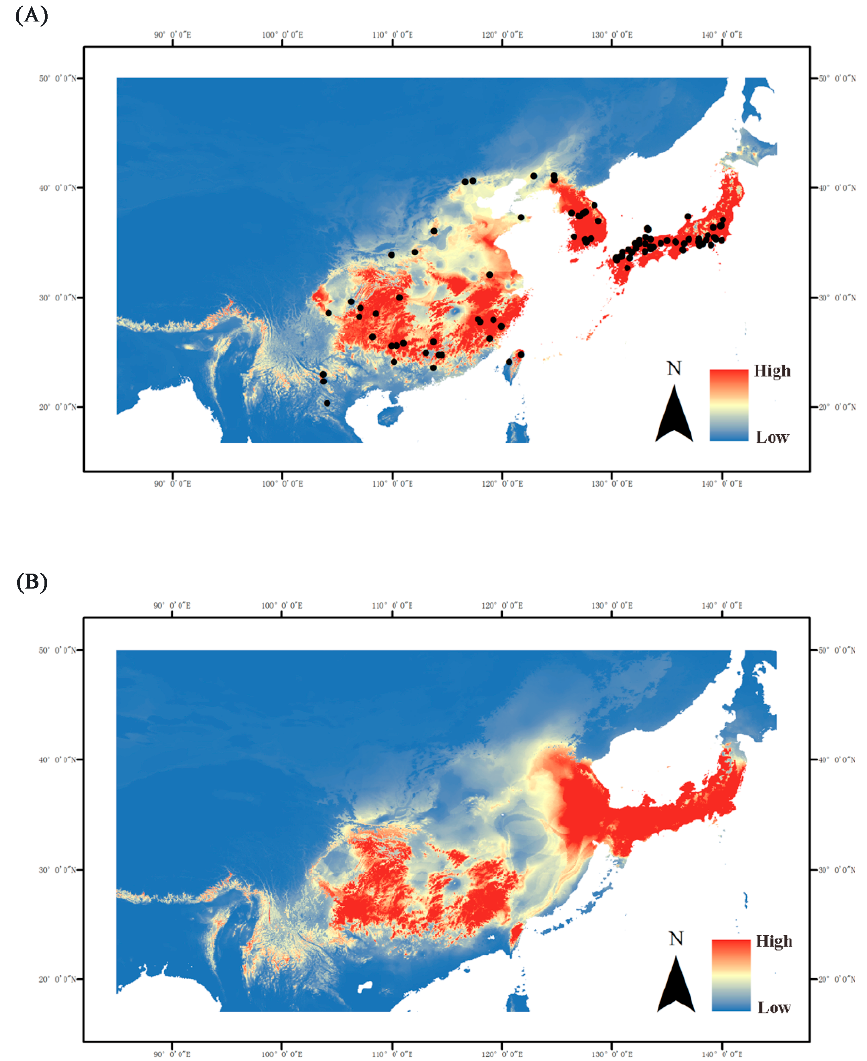
Figure 5. Hindcasting ecological niche models in East Asia during the ( A ) current and ( B ) LGM period. Black dots represent recording localities used to fit the ecological niche model. Blue indicates low suitability, while red indicates high suitability.